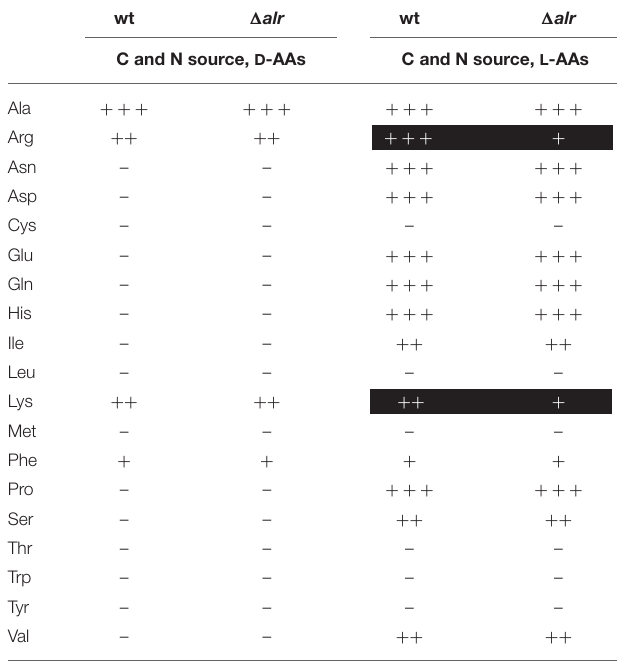
TABLE 3 | Growth profile of Pseudomonas putida KT2440 wt and 1 alr strains on 19 D - or L -AAs as a sole source of C and N. wt 1 alr wt